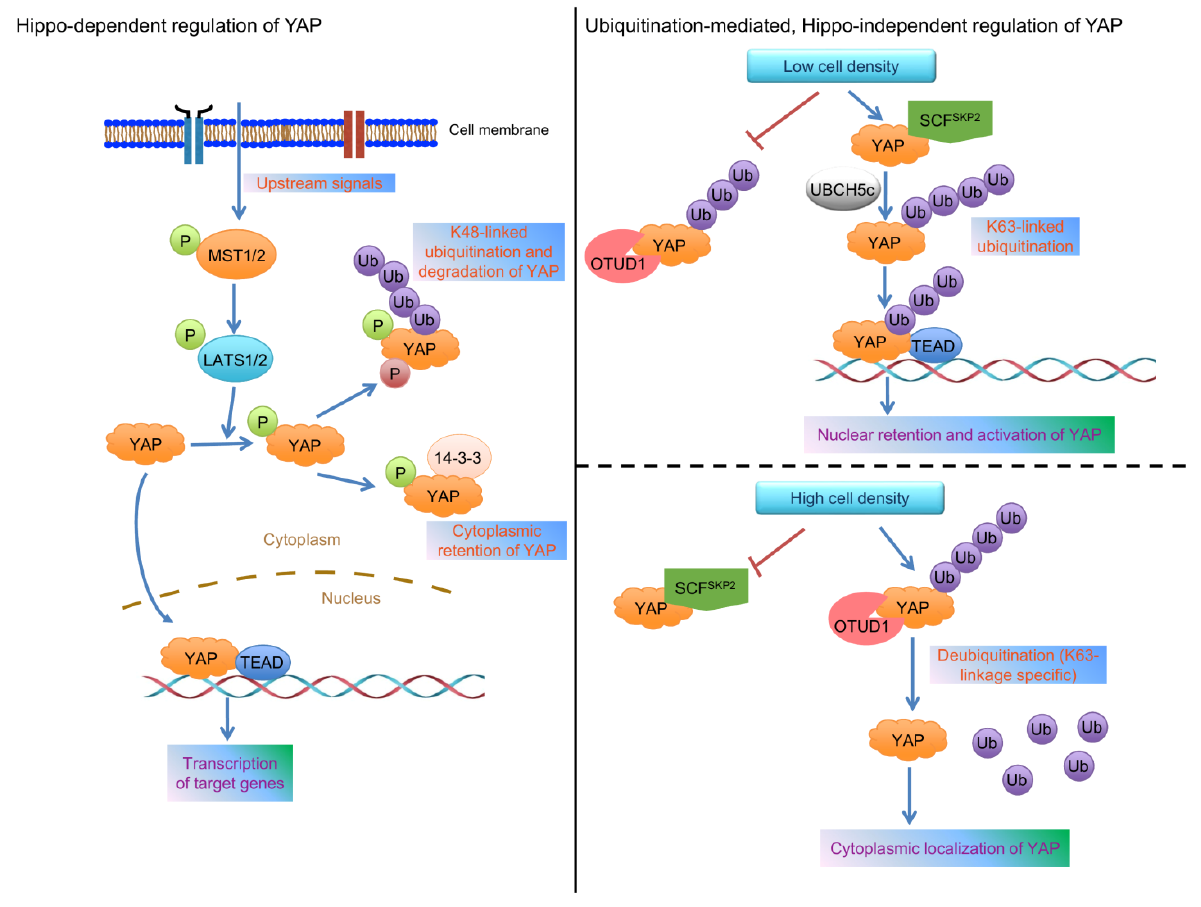
FIGURE 1: Models for the regulation of YAP localization and activity. Left panel: various upstream signals provide inputs that feed into the MST1/2 substrates, LATS1/2, to phosphorylate YAP at Ser127, leading to its binding to 14-3-3, which in turn retains YAP in the cyto- plasm. Moreover, the subsequent phosphorylation of YAP by casein kinase 1 δ / ε triggers the recruitment of the SCF β -TRCP complex, which promotes YAP’s proteolytic ubiquitination under high cell density conditions. Right panel: low cell density promotes SKP2 to interact with and ubiquitinate YAP via the K63 linkage, leading to enhanced YAP-TEAD interaction and nuclear retention of YAP (upper); high cell densi- ty promotes OTUD1 to bind YAP and reverse its K63-linked ubiquitination, leading to cytoplasmic localization of YAP